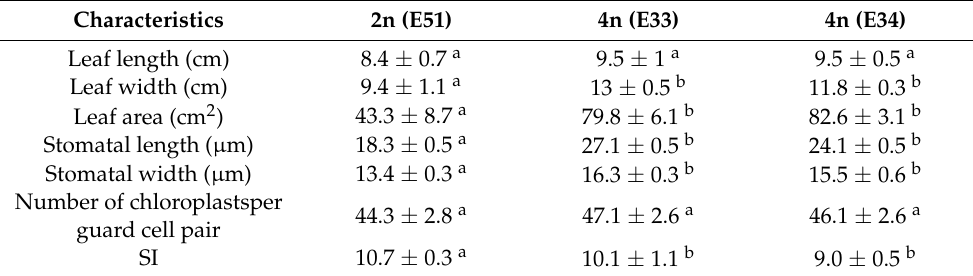
Table 2. Morphological comparison of diploid and tetraploid